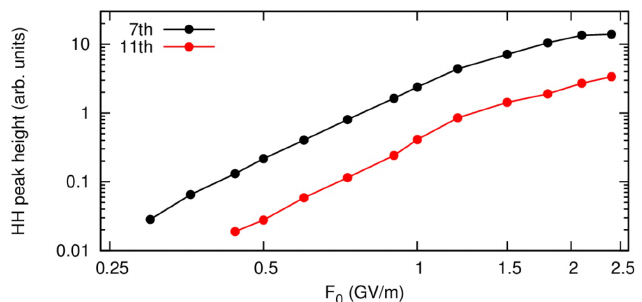
Figure 4. The height of the seventh and 11th high harmonic peak as a function of the peak field strength of the external field. (Please note the log–log scale.)